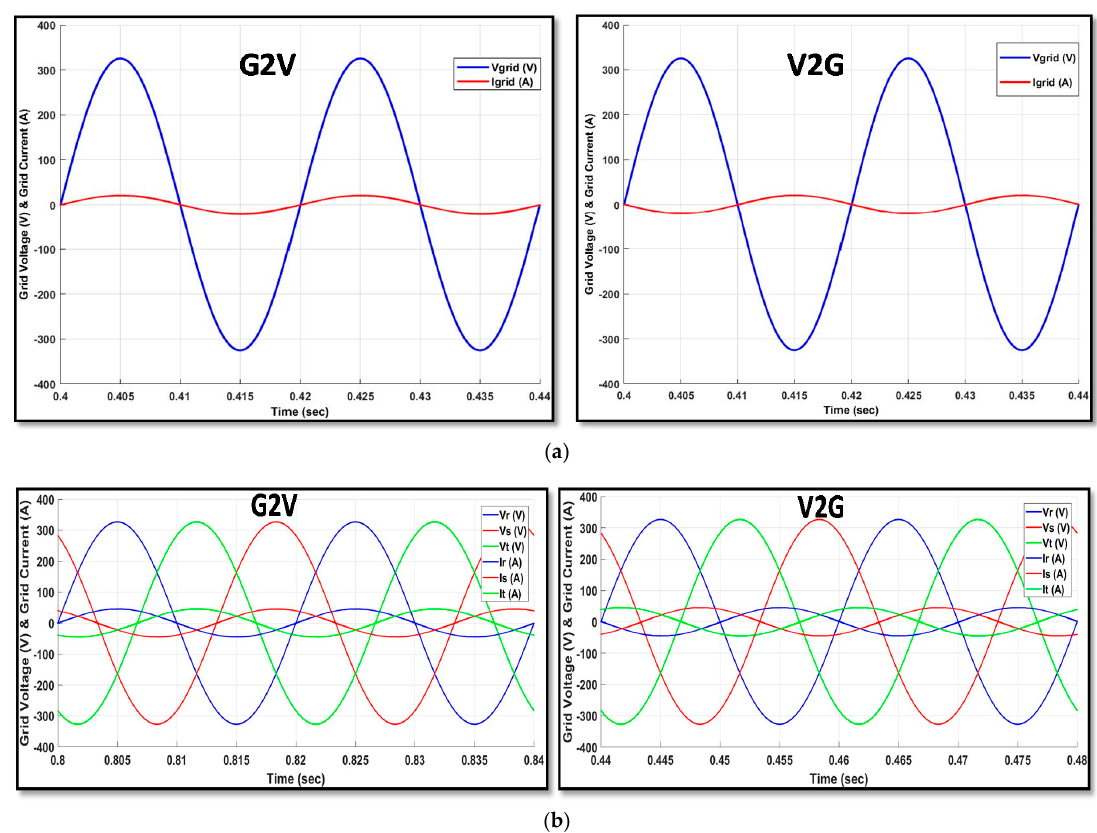
Figure 18. Grid Voltage and Current in G2V and V2G systems. ( a ) Single Phase for Light-Duty Vehicles; ( b ) Three Phase for Heavy-Duty Vehicles.